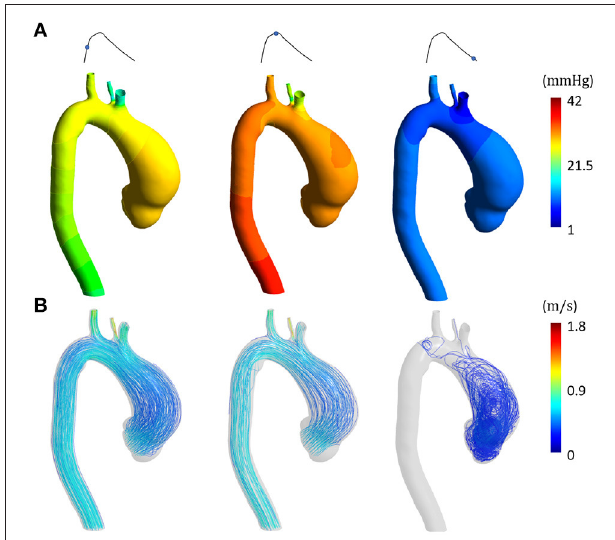
FIGURE 6 | Fluid dynamic results from SOL FSI SD step at early systole, peak systole and late diastole in terms of (A) pressure distribution and (B) velocity streamlines.